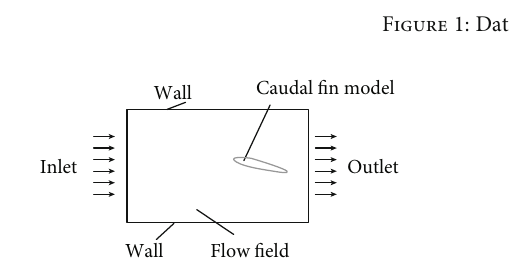
Figure 2: Calculation domain setting. Table 1: Boundary condition setting.